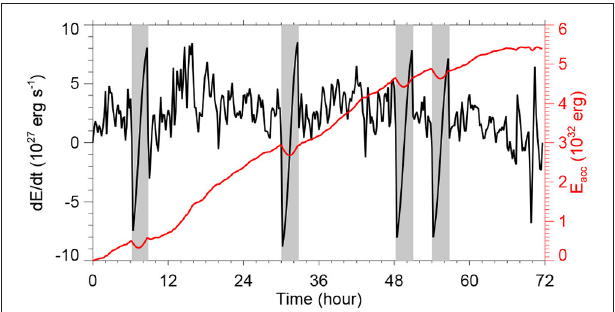
FIGURE 4 | Evolution of Poynting flux (black line) and the accumulated energy (red line) which is time integration of the Poynting flux. The gray bars denote the data gaps of the vector magnetograms for which a simple linear interpolation in time is used to